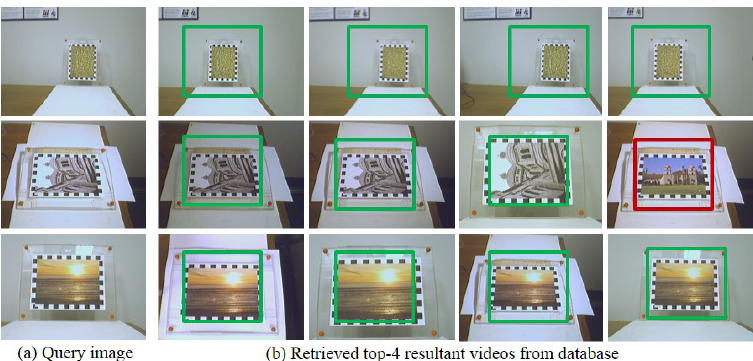
Figure 10. Retrieval results for UCSB dataset: ( a ) Query image and ( b ) Retrieved top-4 resultant videos from database.